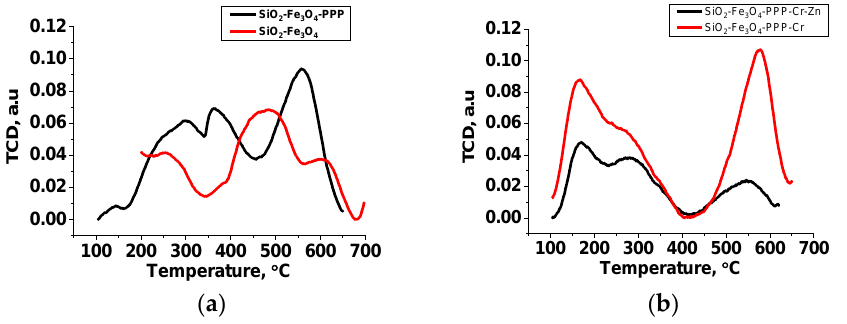
Figure 6. CO 2 -TPD results of the examined catalysts: ( a ) SiO 2 -Fe 3 O 4 (red line) and SiO 2 -Fe 3 O 4 -PPP (black line); and ( b ): SiO 2 -Fe 3 O 4 -PPP-Cr (red line) and SiO 2 -Fe 3 O 4 -PPP-Cr-Zn (black line).